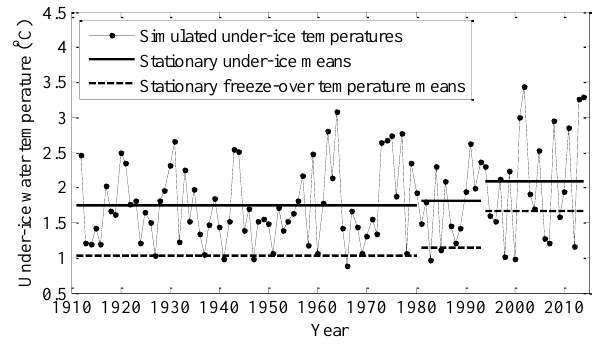
Figure 10. Simulated mean under-ice water temperatures (volume- weighted averages of all depths) during the ice-covered period be- tween 1911 and 2014. The stationary means for three selected peri- ods of under-ice water temperatures and freeze-over water temper- atures are also plotted.